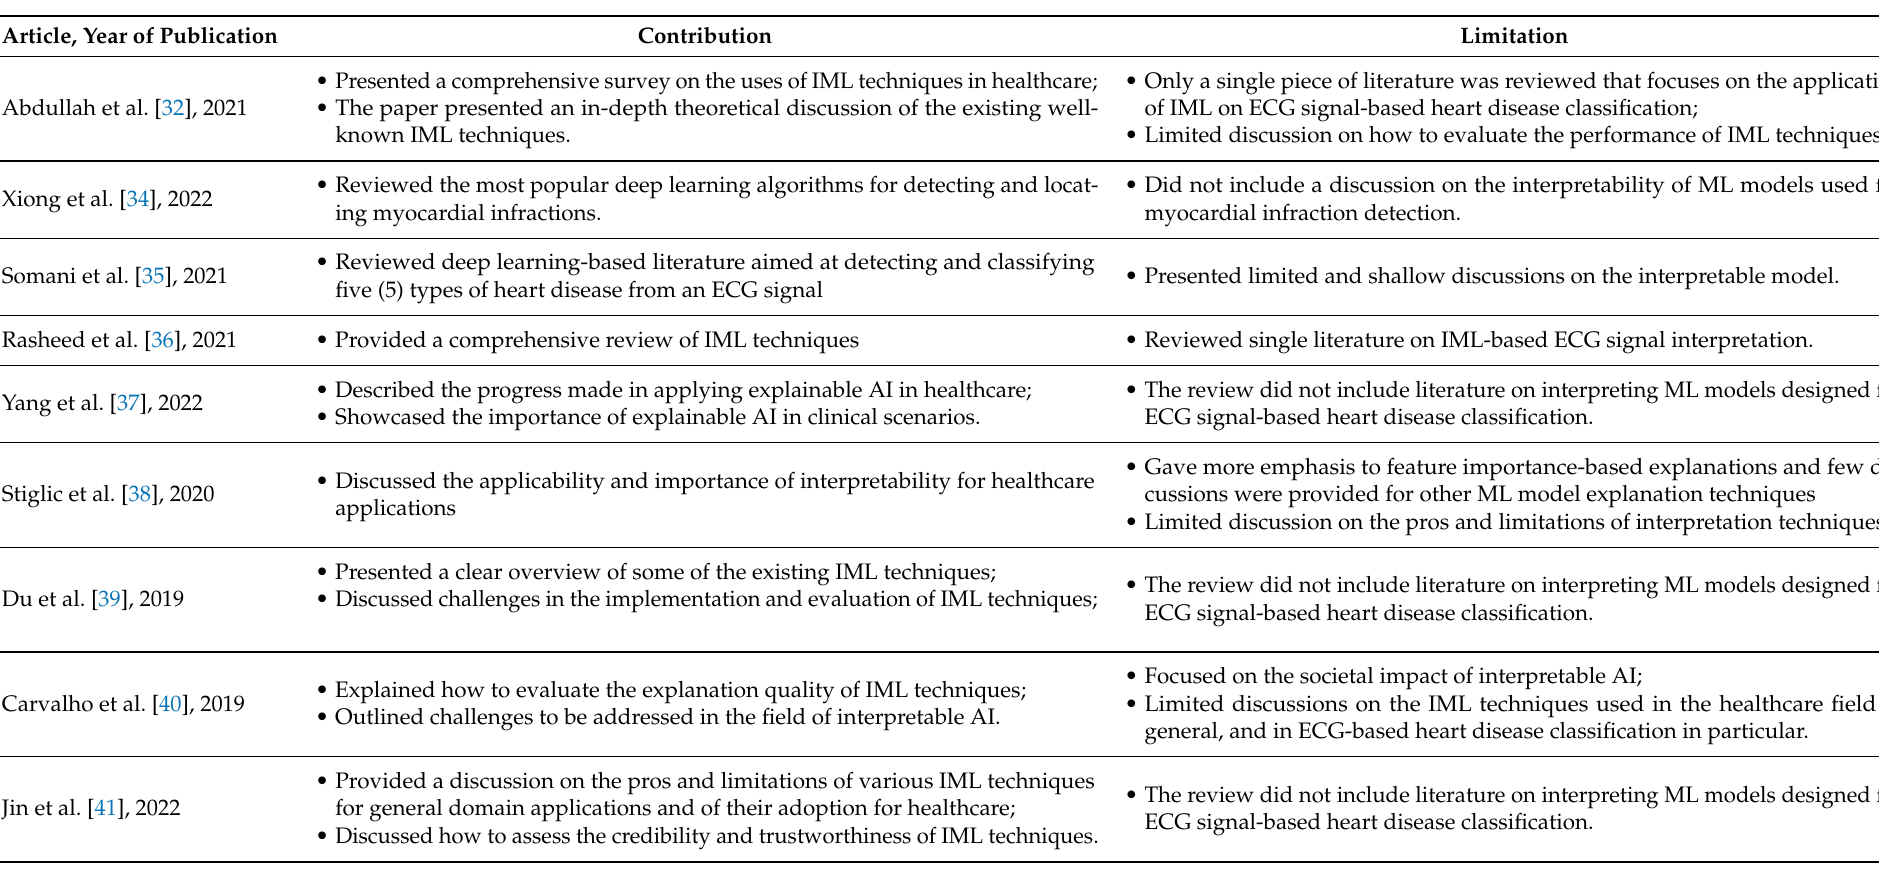
Table 1. Summary of related